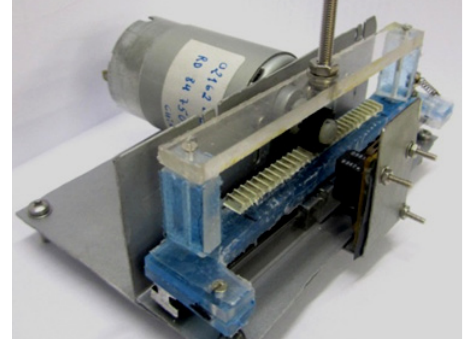
Figure 1. A low cost 1DOF haptic